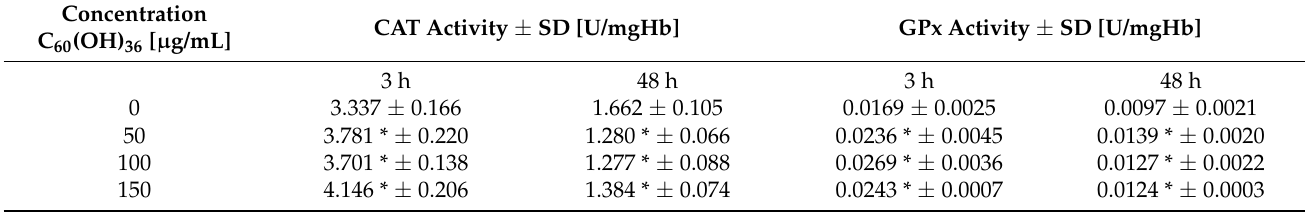
Table 2. Catalase (CAT) and peroxidase (GPx) activity converted into an mg of hemoglobin protein in the suspension of erythrocytes incubated with C 60 (OH) 36 in the concentration range of 0–150 µ g/mL for 3 and 48 h at 37 ◦ C. After incubation, the erythrocytes were subjected to